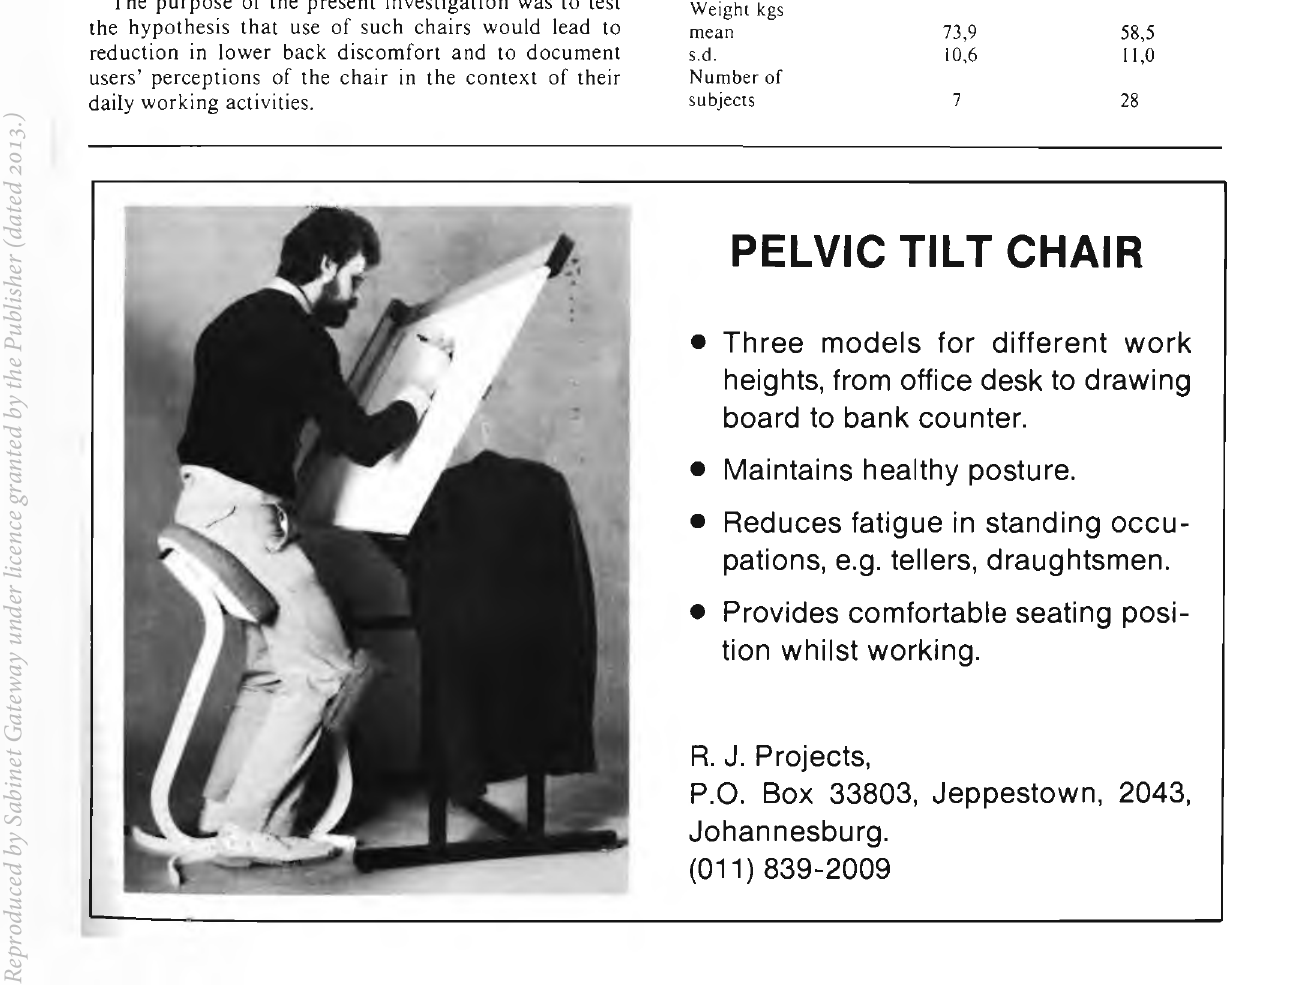
Table I. Personal Characteristics of the sample of lower back pain